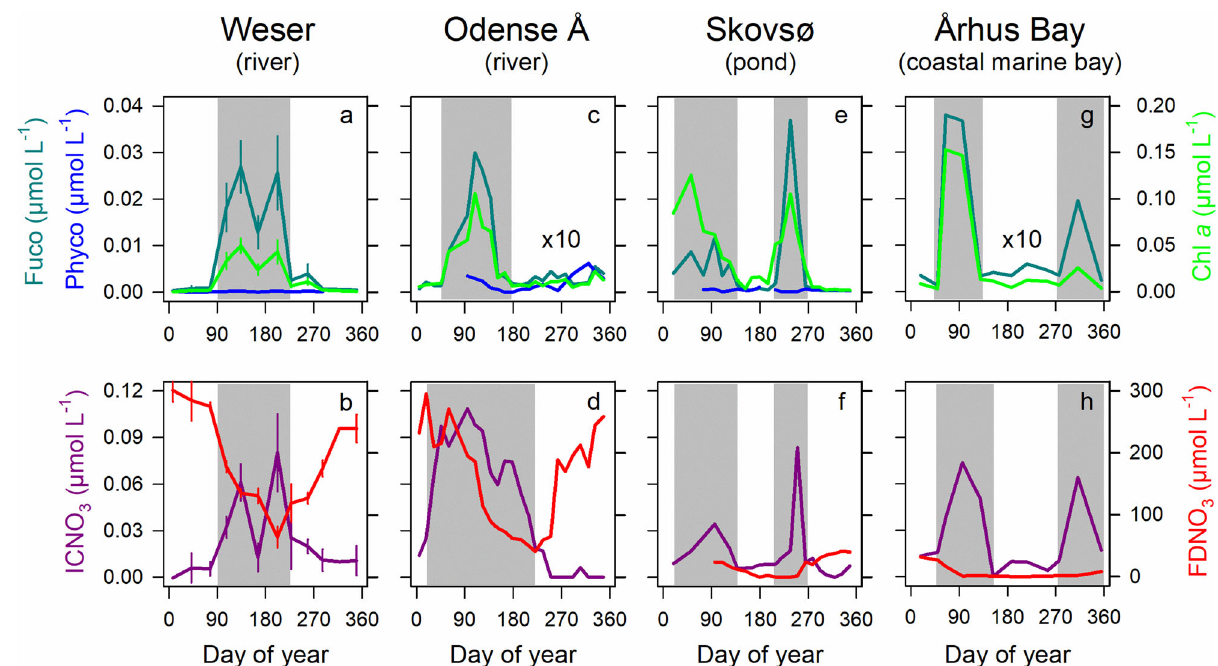
Fig. 5 Seasonal variation of intracellular nitrate. a , c , e , g Water column contents of chlorophyll a (Chl a ), fucoxanthin (Fuco), and phycocyanin (Phyco) and b , d , f , h freely dissolved nitrate (FDNO 3 ) and intracellular nitrate (ICNO 3 ) in two rivers, one pond, and one coastal marine bay. For better visibility, photopigment and nitrate contents were multiplied by an appropriate factor as indicated in the respective panel. Gray shading marks time periods during which fucoxanthin and ICNO 3 maxima appeared. For Århus Bay, no phycocyanin data are available. For Weser, monthly means ± standard deviation of n = 5 were calculated from multiple samplings during 2017 –